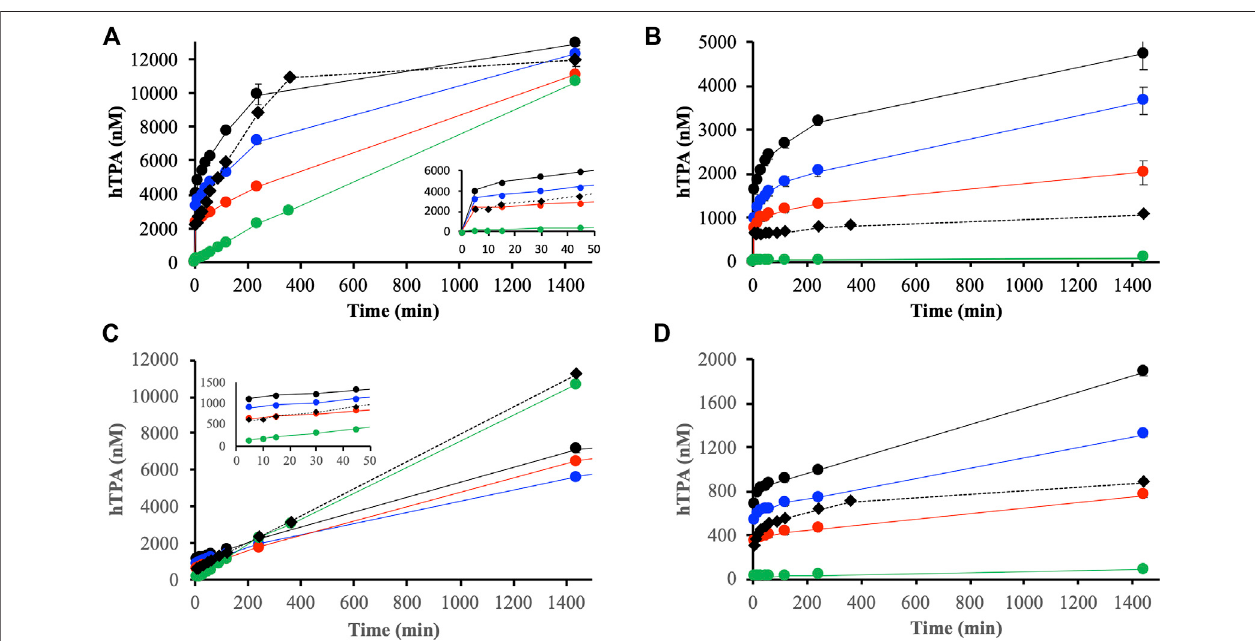
FIGURE 5 | Generation of hydroxyls radicals detected by the oxidation of TPA to hTPA from reactions between H 2 O 2 and suspensions containing DOM mod-EtOAc andferrihydrite (A) andgoethite (B) ,andDOM mod-H2O andferrihydrite (C) andgoethite (D) .TheexperimentswereperformedatTOCconcentrationsof4.0(redsymbols), 8.0 (blue symbols) and 12.0 μ mol m − 2 (black symbols), and the green symbols represent the reaction between H 2 O 2 and ferrihydrite or goethite in the absence of DOM fraction. Filled circles and solid lines represent experiments where H 2 O 2 was added to suspension containing DOM fractions and iron oxides pre-equilibrated for 24 h. The fi lled diamonds and dotted lines represent experiments where H 2 O 2 and DOM fractions were added simultaneously to the suspensions. All experiments were performed at pH 4.0, [TPA] = 300 μ M and [H 2 O 2 ] = 100 μ M. The data points represent the average of triplicate experiments, and the standard deviations in hTPA concentrations are in most cases smaller than the size of the symbols. The insets in (A,C) show the initial time points 0 – 50 min.